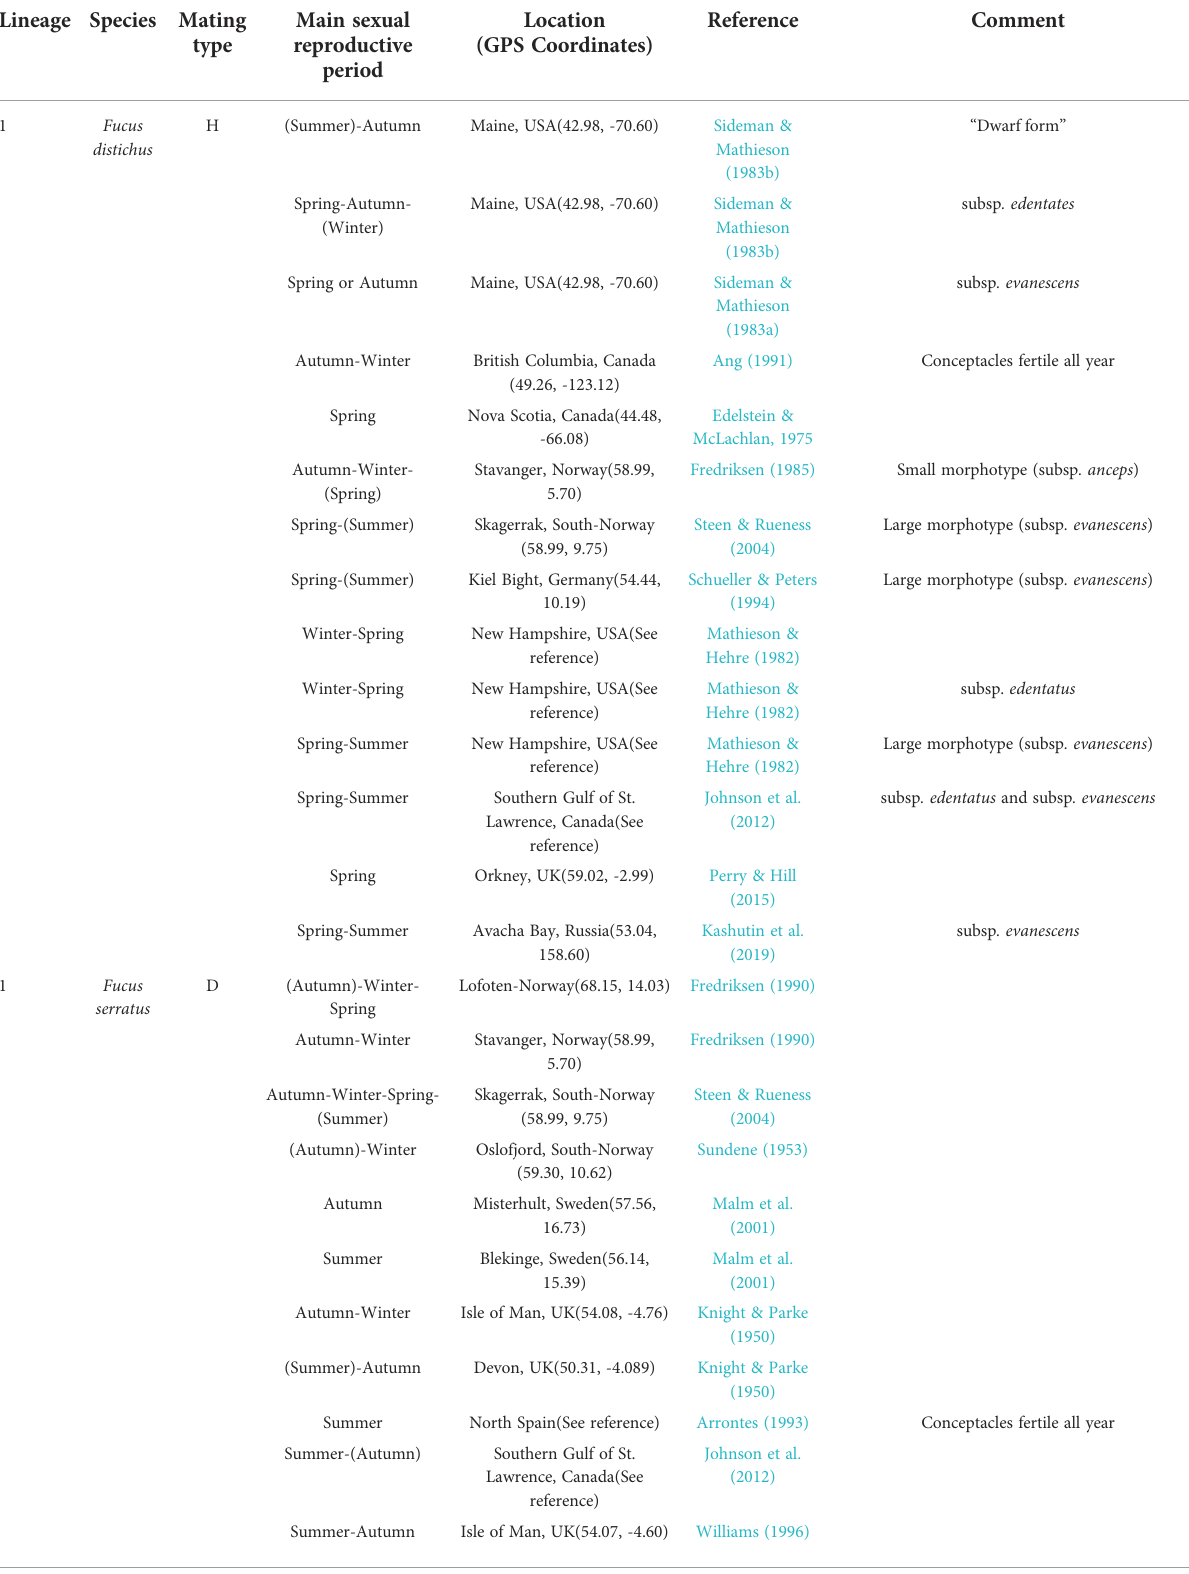
TABLE 1 Main reproductive period for Fucus spp. as recorded in different